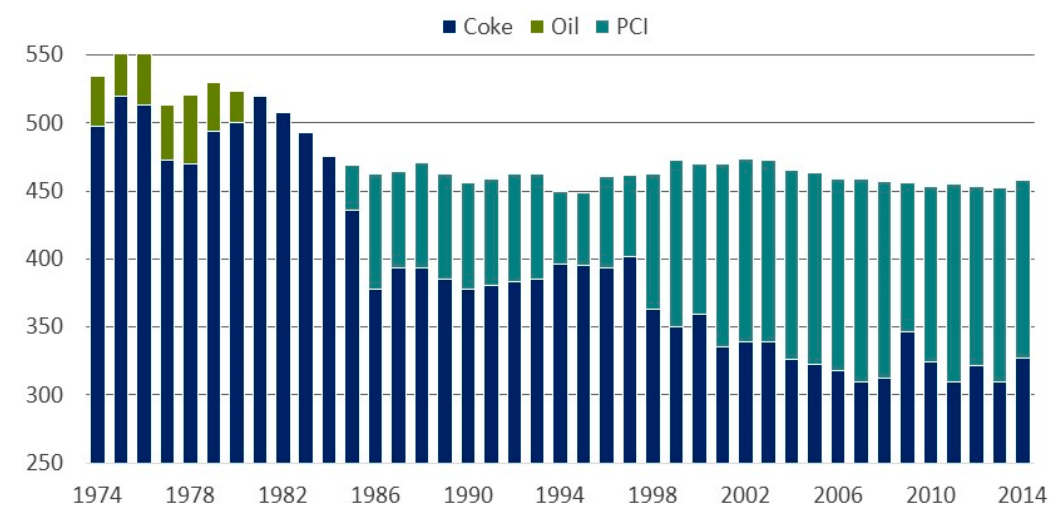
Figure 5. Development of the fuel rate in the blast furnace at SSAB in Luleå, Sweden.